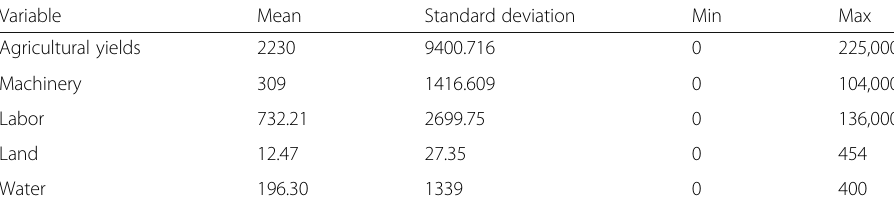
Table 2 Descriptive statistics